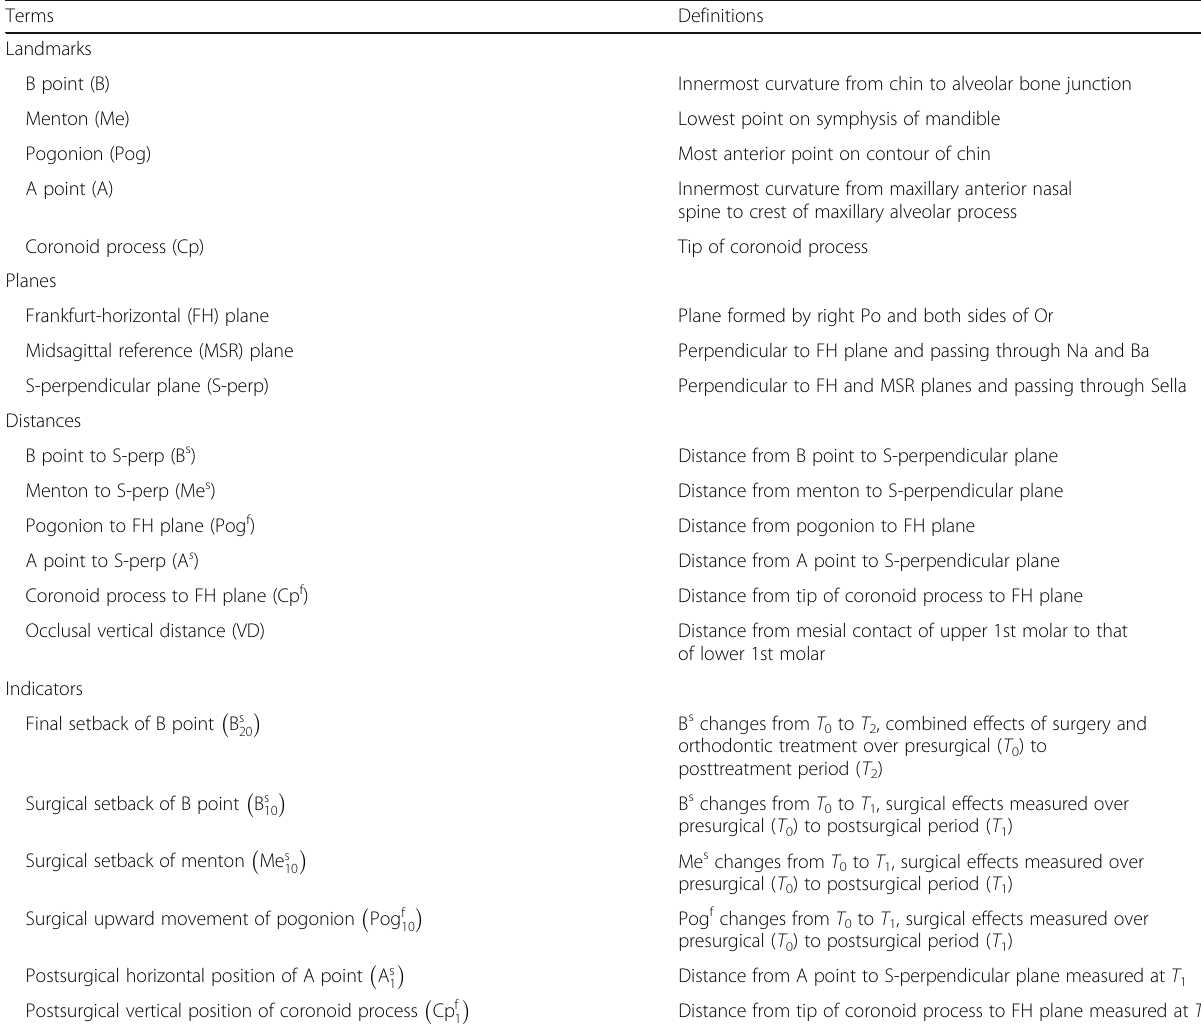
Table 1 Model-relevant landmarks, planes, distances, and